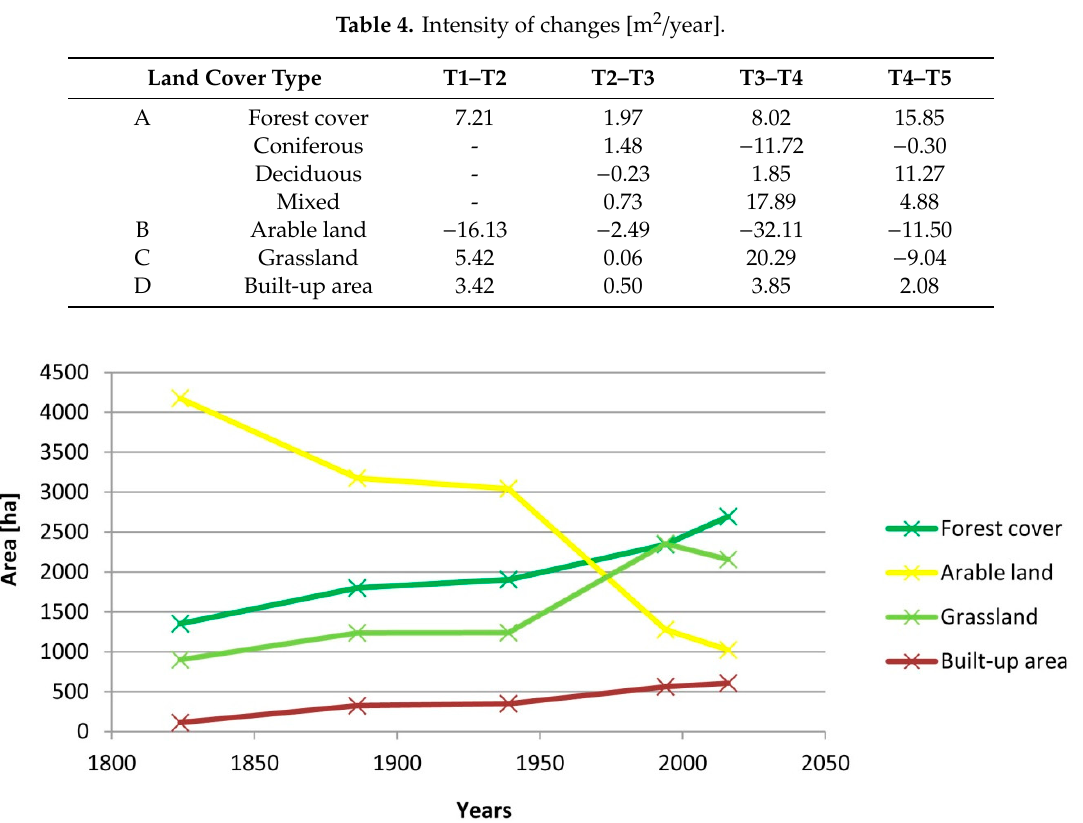
Figure 3. Change in forest cover (ha) in the studied area in the years 1824–2016 against other land cover form changes.